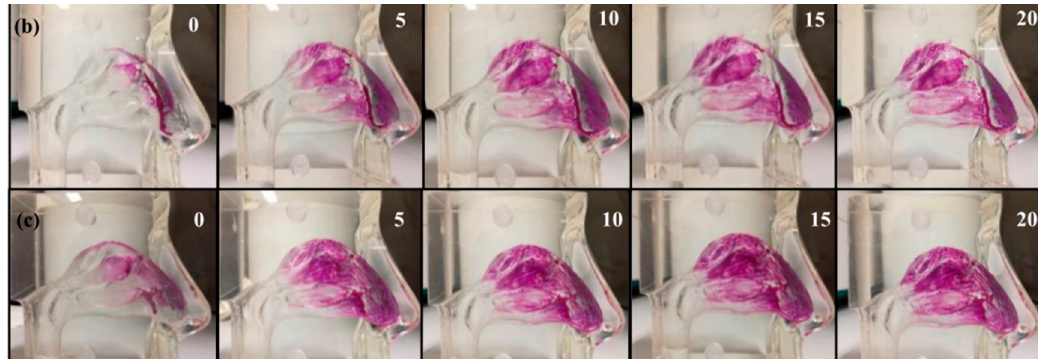
Figure 17. Representation of gelation temperature.